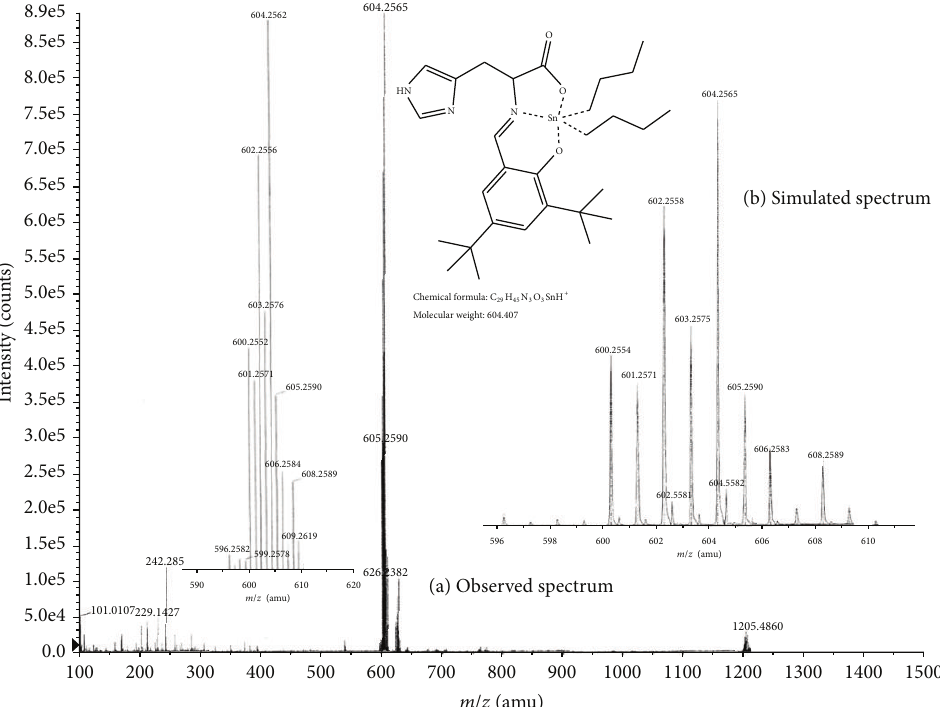
Figure 3: Observed mass spectrum (a) and simulated spectrum (b) of complex 2